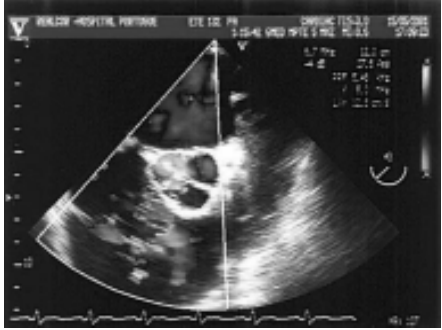
Fig. 2 – Aspect of the transoesophageal echocardiogram, showing aortic failure